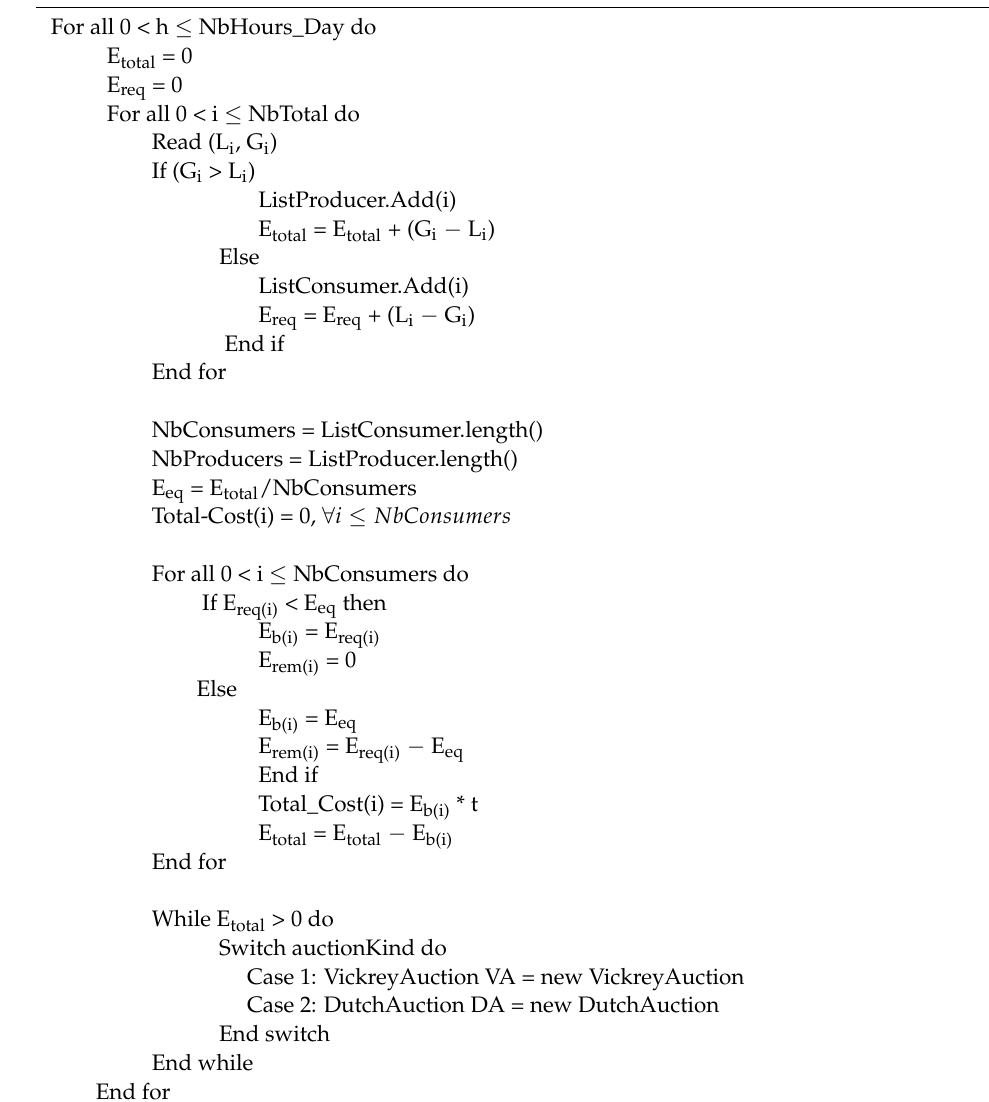
Algorithm 3. Completely Fair